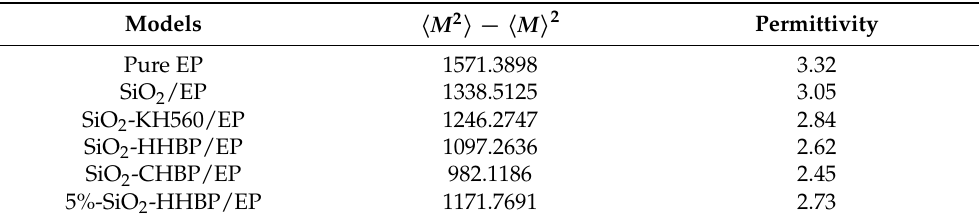
Table 4. The fluctuation of the dipole moments and the permittivity of models.